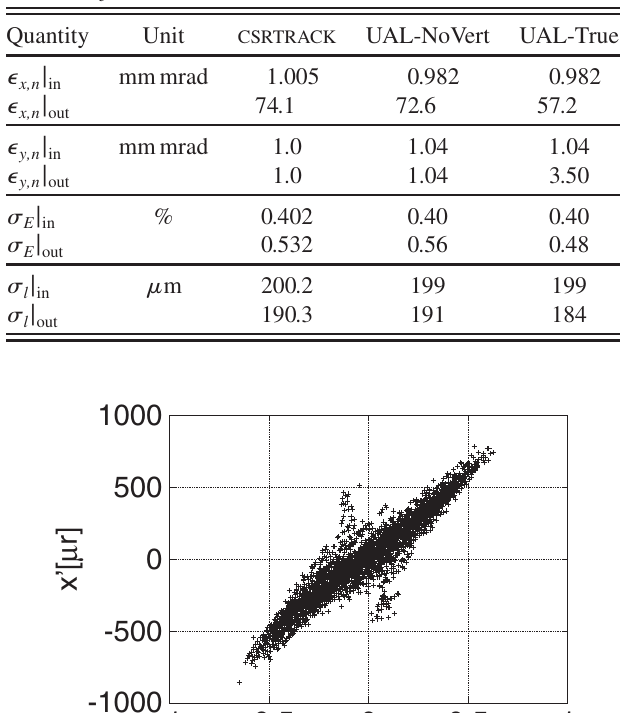
TABLE IV. Simulation results for (low energy) standard chi- cane at E e ¼ 50 MeV .